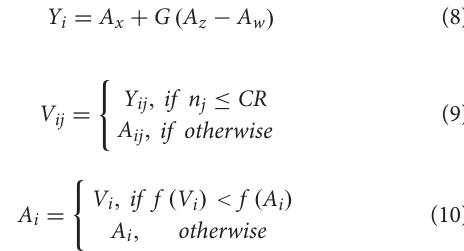
a number of solutions are found, and to the next algorithm, a new population is